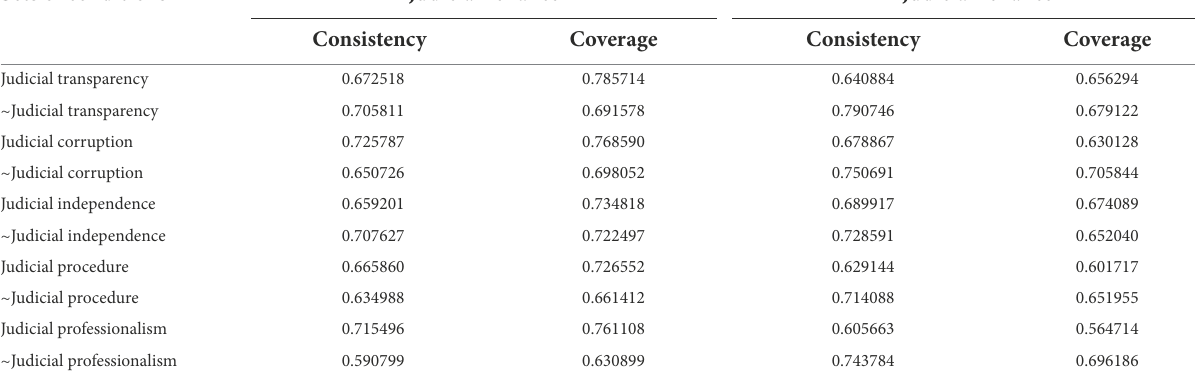
TABLE 3 Analysis of necessary conditions for high and low judicial reliance. Sets of